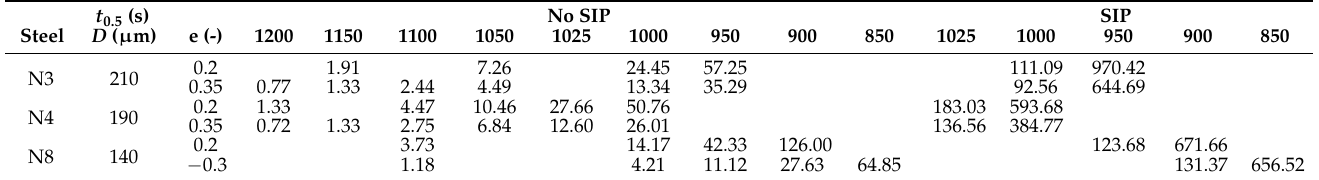
Table 3. Values of t 0.5 in the JMAK equation.